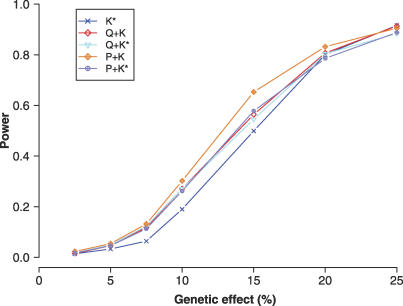
Power to Detect Associations Using a Nominal 0.1% Significance LevelThe QTN is assumed to lie within a sequenced haplotype, but power is nonetheless poor even for major QTL.